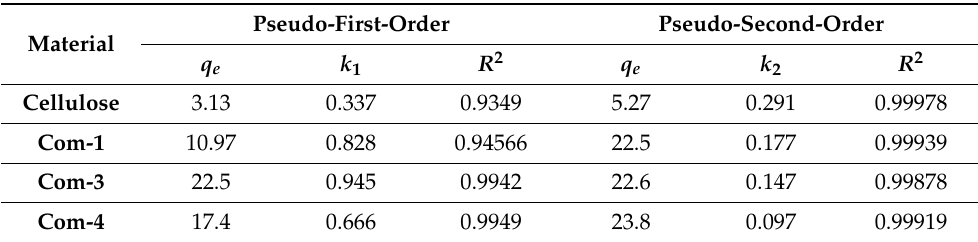
Table 2. Constants and correlation coefficients for the kinetic